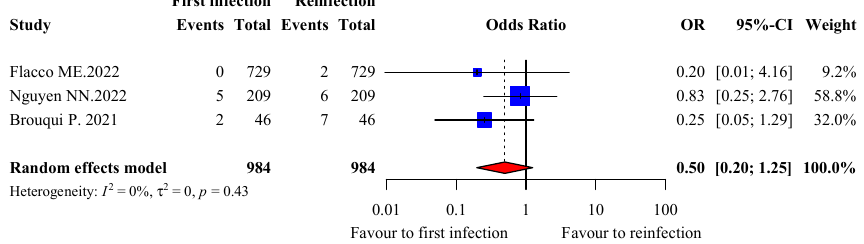
Figure 3. Forest plot of hospitalisations during the first and second infection.